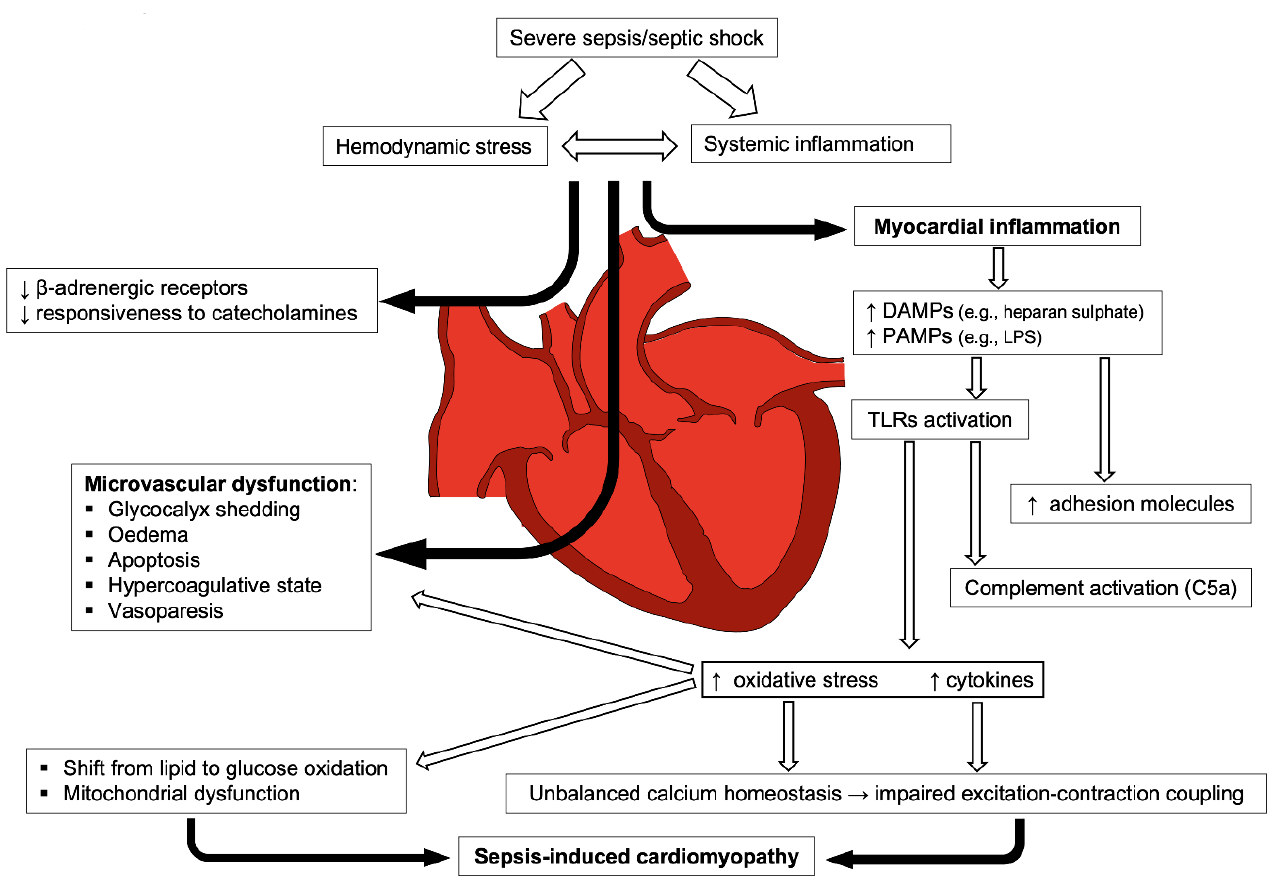
Figure 2. Hemodynamic stress and systemic inflammation exert a synergistic effect on myocardial function impairment during sepsis. Systemic response to sepsis triggers and sustains myocardial dysfunction through several pathways: by impairing the compensatory reaction of sympathetic system with consequent microvascular dysfunction and—In parallel—through theimmune system activation and microvascular dysfunction (black arrows). Those mechanisms deeply impair myocardial tissue through a cascade involving damage- and pathogen-associated molecular pattern (DAMPs and PAMPs, respectively), Toll-like receptors (TLRs), complement and release of cytokines and reactive oxygen species.